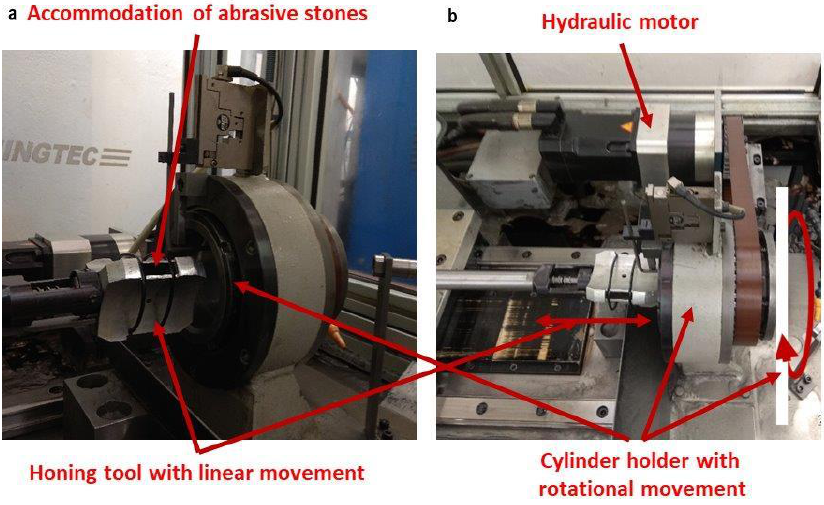
Figure 1. Honing test machine used: ( a ) Front view; ( b ) top view.